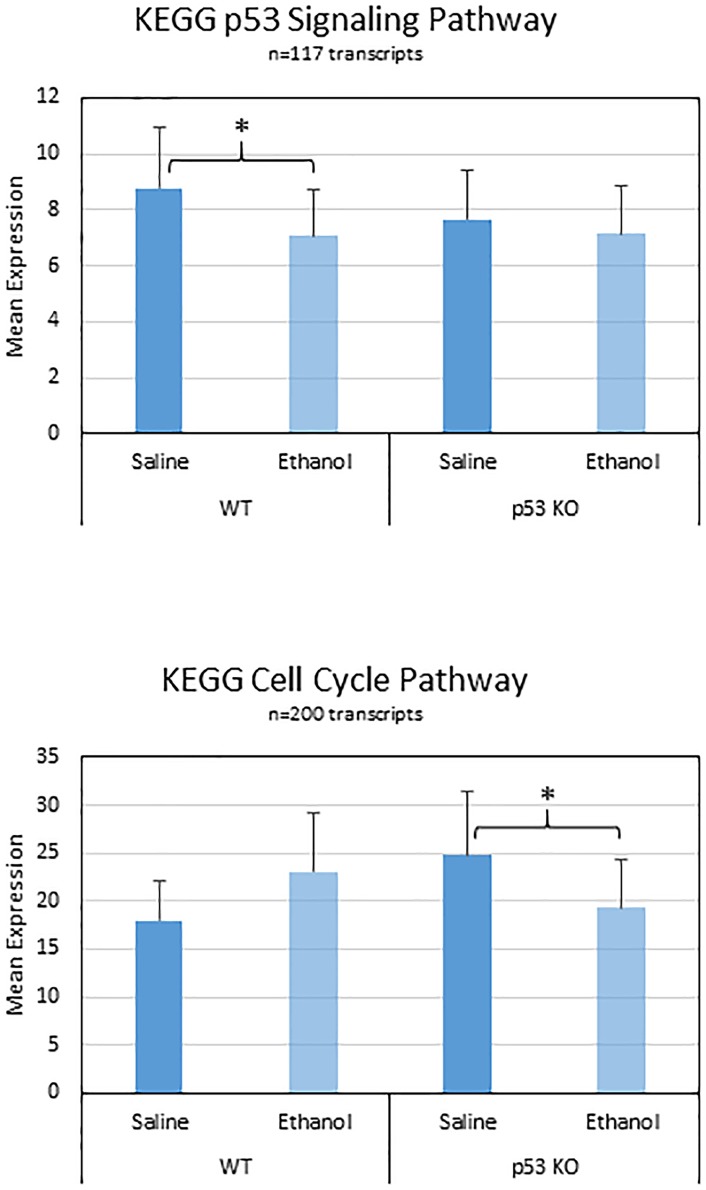
Ethanol-induced changes in the p53 Signaling Pathway and Cell Cycling Pathway.The transcripts contained with each of these KEGG pathways were averaged for each condition. There were trends for decreased expression in the p53 Signaling in the WT mice (upper) and for differential responses to ethanol in the WT and p53 KO mice (lower). Cell Cycle changes were confirmed by a significant Genotype x Treatment interaction from the Pathway ANOVA results. Bars show mean, T-bars depict standard error of the mean. Asterisks indicate significant (p<0.05) post-hoc contrasts within each genotype for the ethanol versus saline comparison.